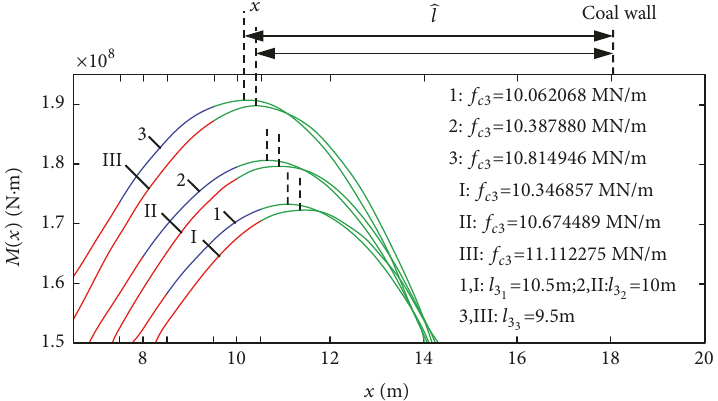
Figure 18: Enlarged drawings at peak part of rock beam bending moment for different softening area